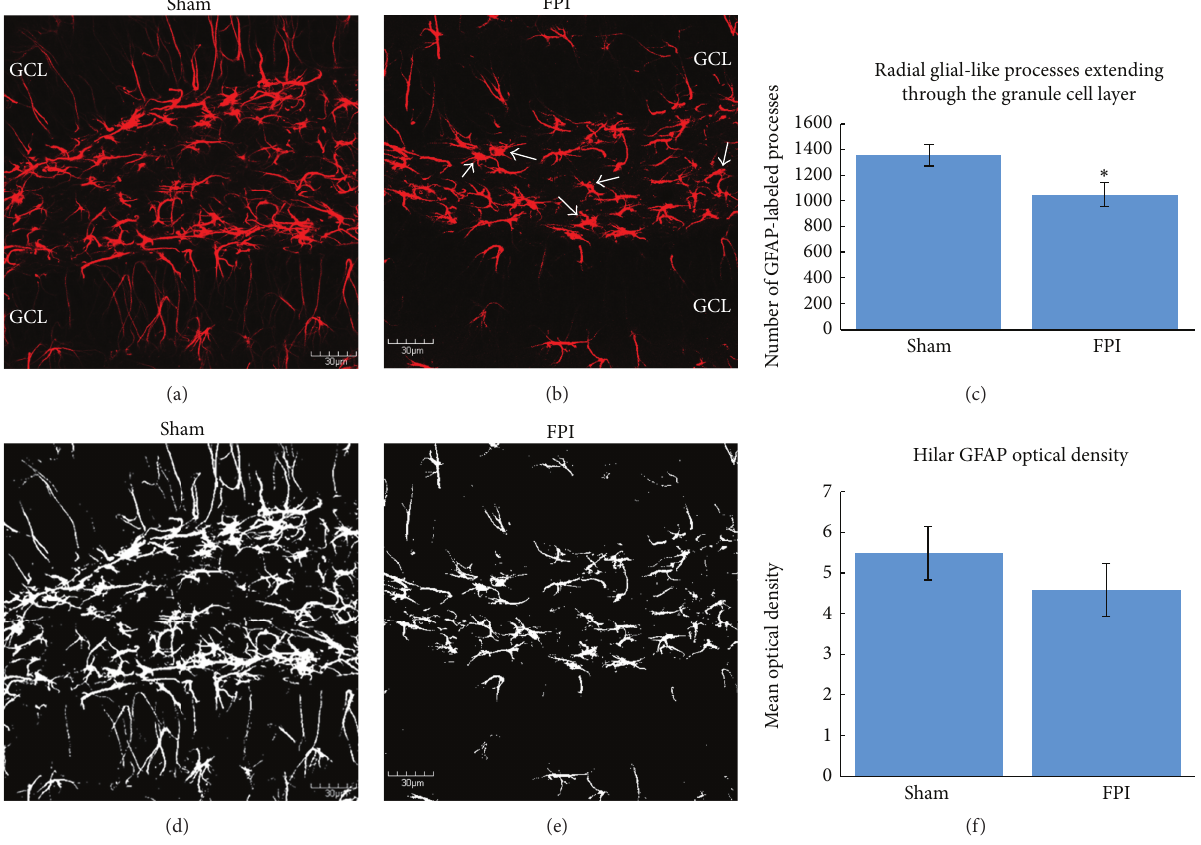
Figure 3: GFAP-labeled cells in the dentate gyrus. In (a), a confocal micrograph from a sham mouse is shown to depict the normal appearance of a robust number of radial glial processes extending through the granule cell layer (GCL). In (b), a representative confocal micrograph of an FPI mouse shows a decrease in the number of radial glial-like processes extending through the GCL. In addition to the lack of radial glial processes extending through the GCL, note that several GFAP-labeled astrocytes from FPI mice displayed varying levels of activated morphology in the hilus (arrows). In (c), quantitative analysis of the number of radial glial processes extending through the granule cell layer reveals a significant decrease ( ∗ 𝑃 < 0.05) in FPI mice compared to sham mice. In (d), the sham micrograph from (a) is shown after thresholding, to depict the technique used for densitometric analysis of GFAP-labeling in the hilus. Once thresholded, the Image J software (NIH v.1.49) automates the counting of white pixels. In (e), the micrograph from the FPI mouse is shown after thresholding. In (f), densitometric analysis of GFAP-labeled astrocytes in the hilus revealed no significant differences between sham and FPI mice at 30 days after FPI. It is pertinent to note that the subgranular zone was excluded from this analysis (as shown in Figure 1) because the cells in this region have a different appearance than they do in the hilus. Scale bars in all images = 30 𝜇